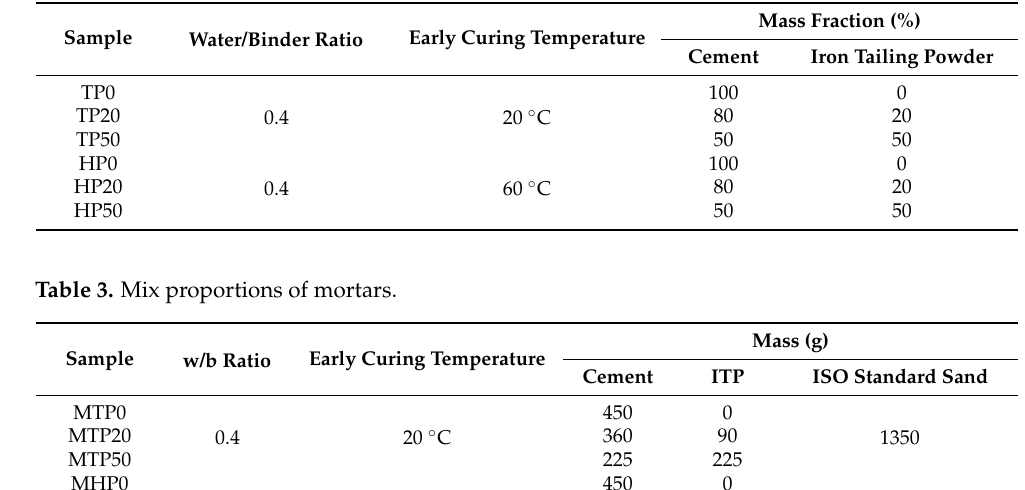
Table 2. Mix proportions of pastes.